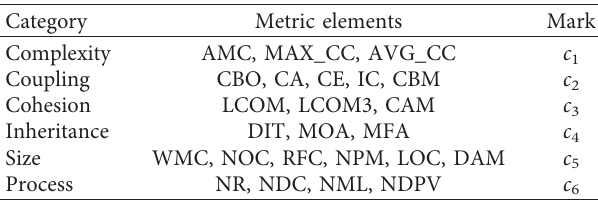
Table 4: Input series of the RNN- c